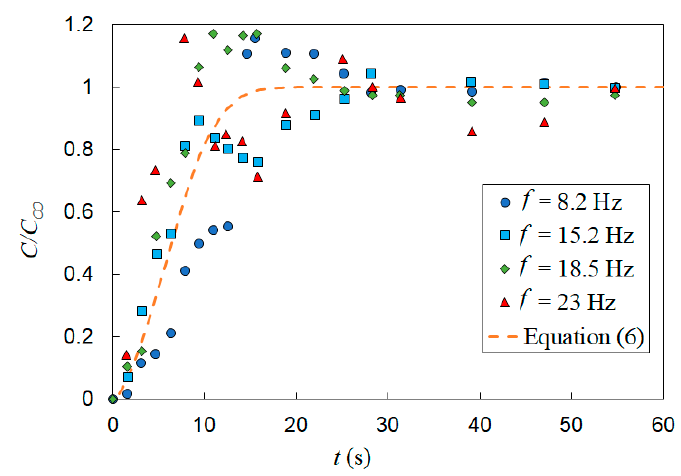
Figure 12. E ff ect of vibration frequency on mixing time, A = 0.6 mm and U SG = 11 mm / s. The horizontal Figure 12. Effect of vibration frequency on mixing time, A = 0.6 mm and U SG = 11 mm/s. The horizontal dashed line represents the fully mixed condition (C / C ∞ = 0.95) and the vertical dashed line t = 9 s. dashed line represents the fully mixed condition (C/C ∞ = 0.95) and the vertical dashed line t = 9 s. Table 3. Operation conditions used in Figure 12 to study the e ff ect of vibration frequency on mixing time. Table 3. Operation conditions used in Figure 12 to study the effect of vibration frequency on mixing time.